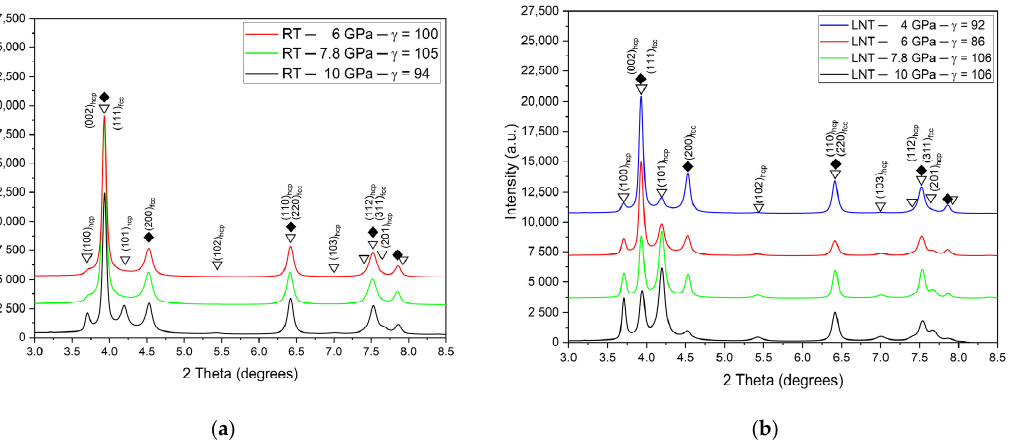
Figure 3. X-ray diffractograms after HPT under different pressures at RT ( a ) and LNT ( b ).